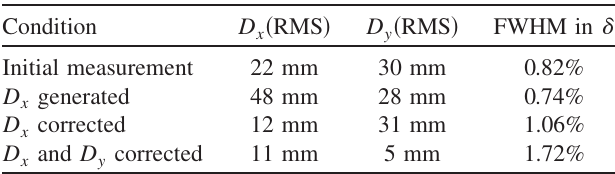
TABLE I. Summary of measurements on SASE energy sensi- tivity to relative electron beam energy offset.